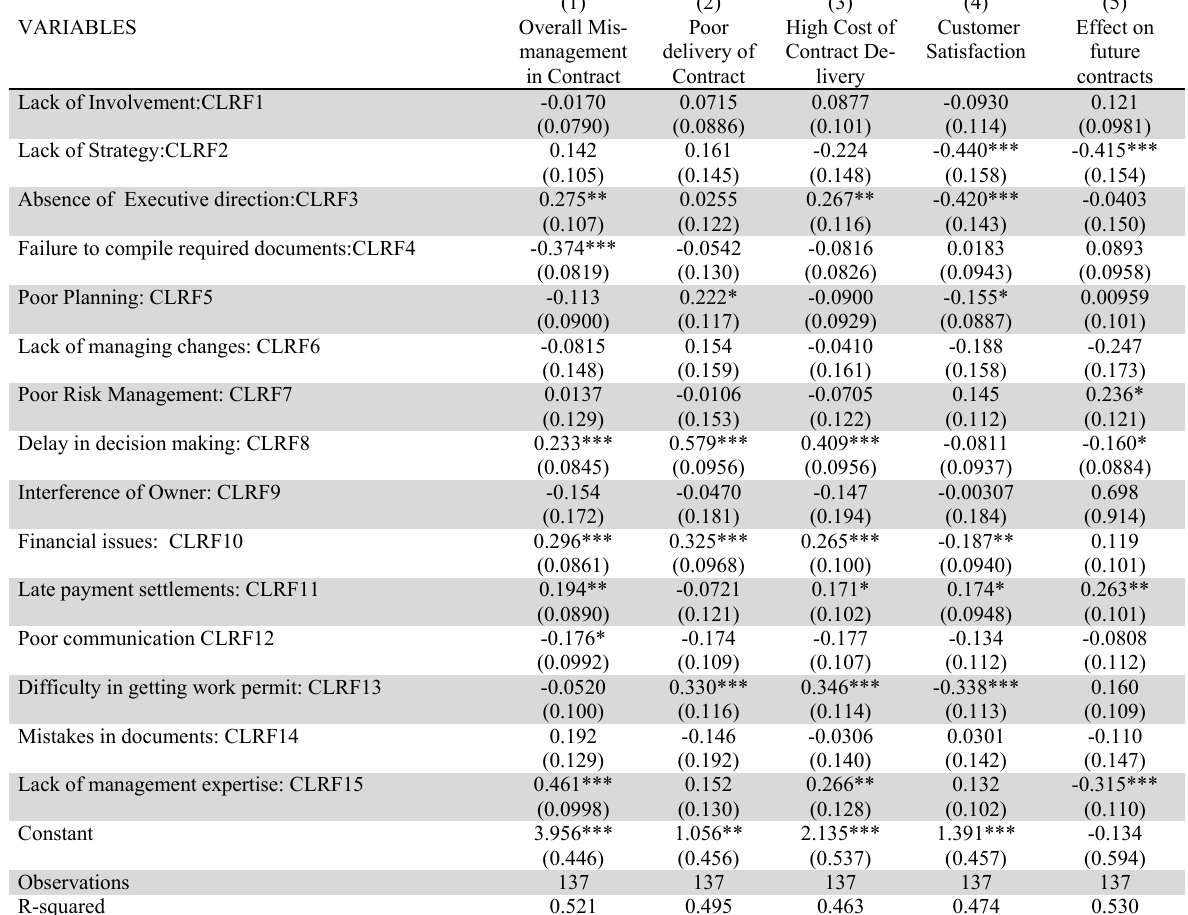
Mismanagement in Contract (Client Related